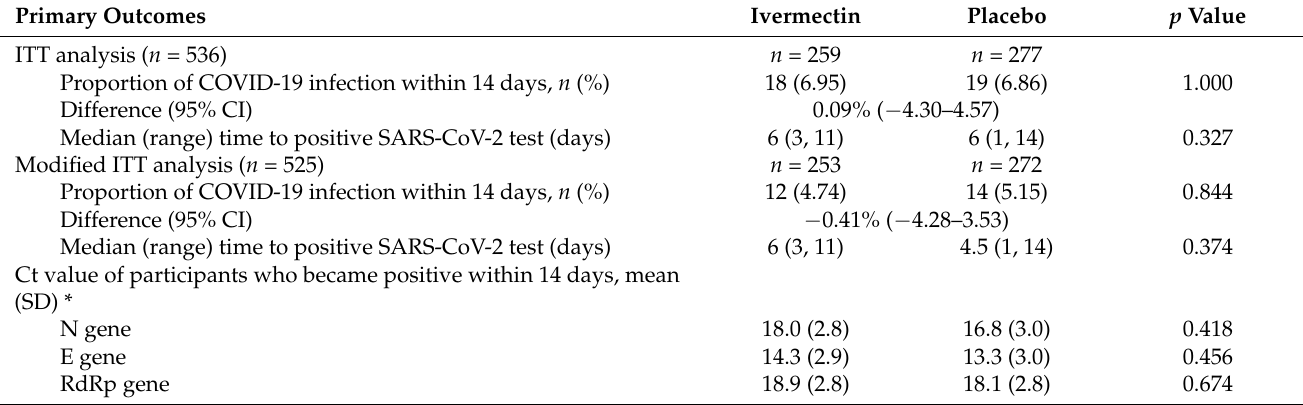
Table 2. Primary outcomes of the ivermectin prevention study classified by ITT and mITT